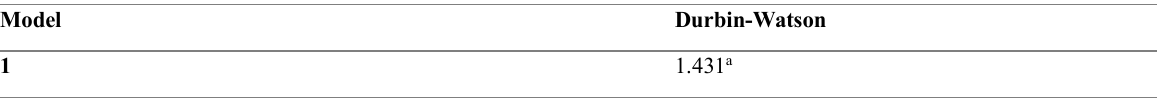
Table 10: Model summary